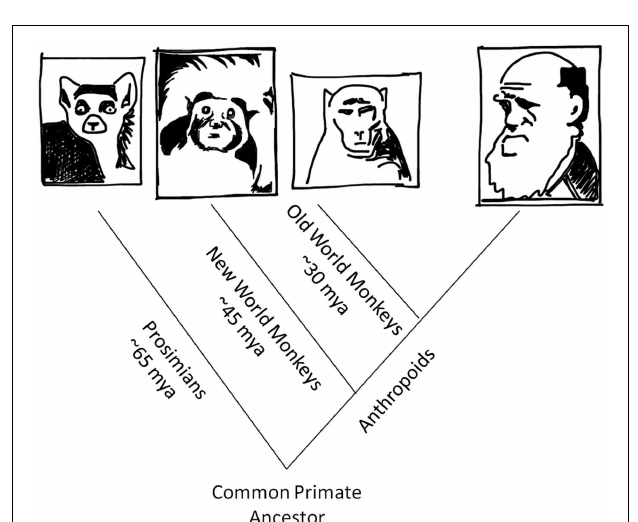
FIGURE 6 | Evolutionary tree stemming for a common primate ancestor to prosimians (e.g., the ring-tailed lemur shown here), which departed from the anthropoid line approximately 65 million years ago; to NewWorld monkeys (e.g., the cotton-top tamarin shown here), which departed from the anthropoid line approximately 45 million years ago; to OldWorld monkeys (e.g., the macaque shown here), which departed from the anthropoid line approximately 30 million years ago; and to Homo sapiens (e.g., Charles Darwin shown here) .